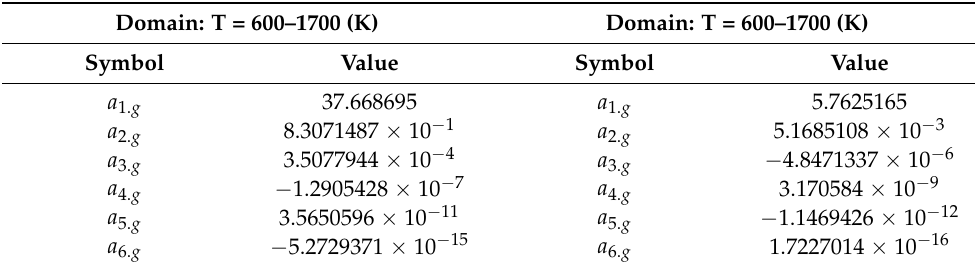
Table 3. Gas enthalpy and entropy polynomial